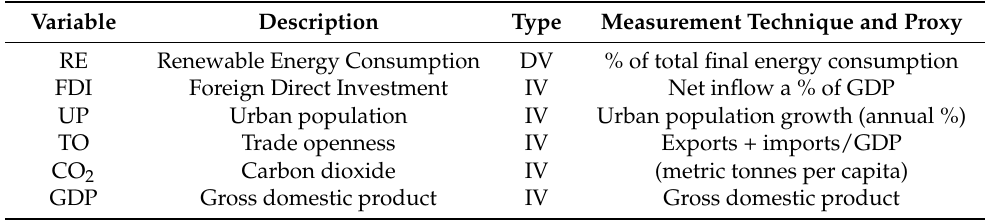
Table 1. Measurement of